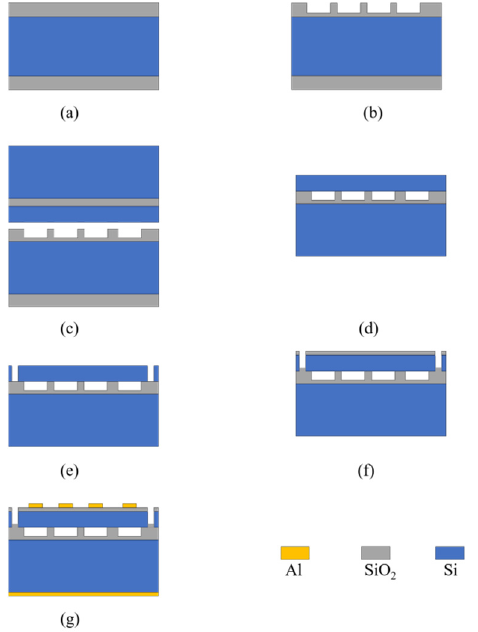
Figure 5. Process flow diagram: ( a ) Oxide wafer and SOI wafer preparation; ( b ) Etching of the cavity on the oxide layer of the oxide sheet; ( c ) Silicon wafer bonding of oxide wafers and SOI wafers; ( d ) Substrate layer and Buried Oxide Layer thinning; ( e ) Etching of the isolation slot on the membrane; ( f ) Silicon oxide deposition as an electrical isolation layer; ( g ) The metal is deposited and patterned as the upper electrode, and the entire lower surface is sputtered as the lower